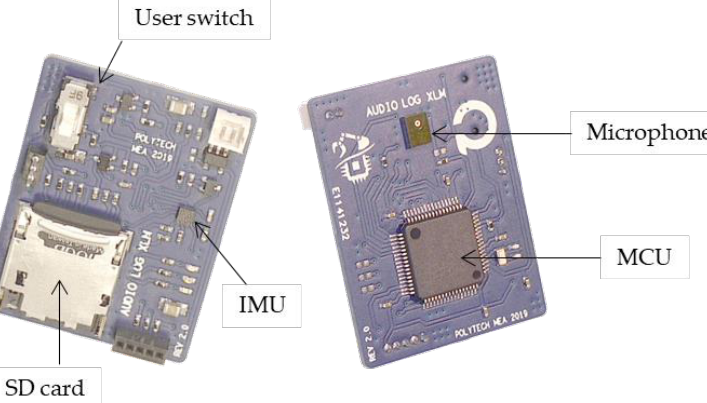
Figure 14. Picture of the batch-fabricated logger